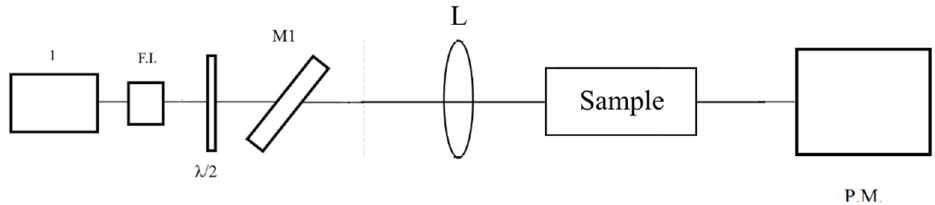
Figure 4. Optical schematic layout of the experimental setup: 1 is the Ho:YAG laser, F.I. is the Faraday isolator, λ /2 is the half-wave plate, M1 is the polarizing mirror, L is the lens, and P.M. is the Ophir power meter.